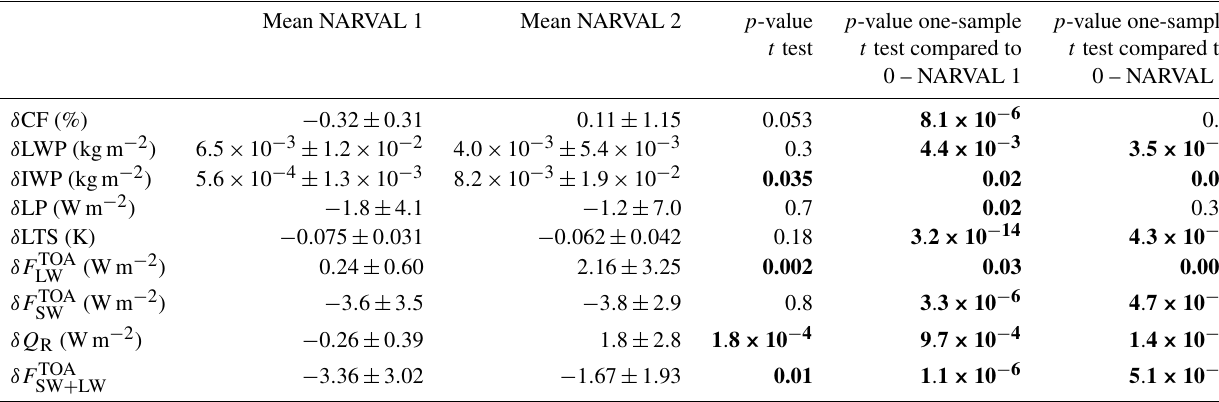
Table 2. Summary of monthly mean response of cloud and atmospheric properties (presented in Fig. 5) to the CDNC perturbation (polluted simulations minus clean simulations) ± 1 standard deviation for each month. In addition, the p values of the two-sample independent t test are presented, as well as the p values for comparing the CDNC response in each month to zero. The p values which demonstrate a significant difference ( < 0 . 05) are presented in